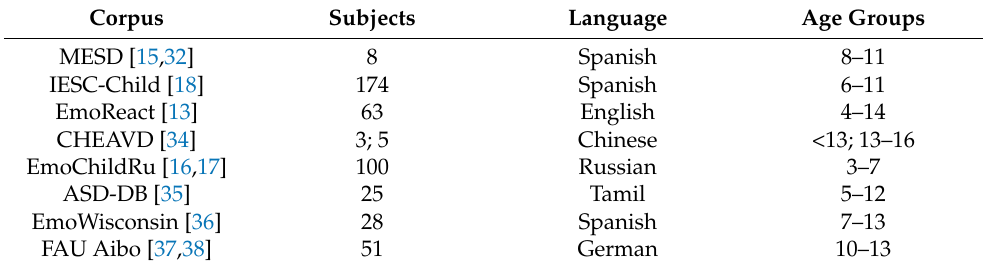
Table 1. Corpora of children’s emotional speech—main